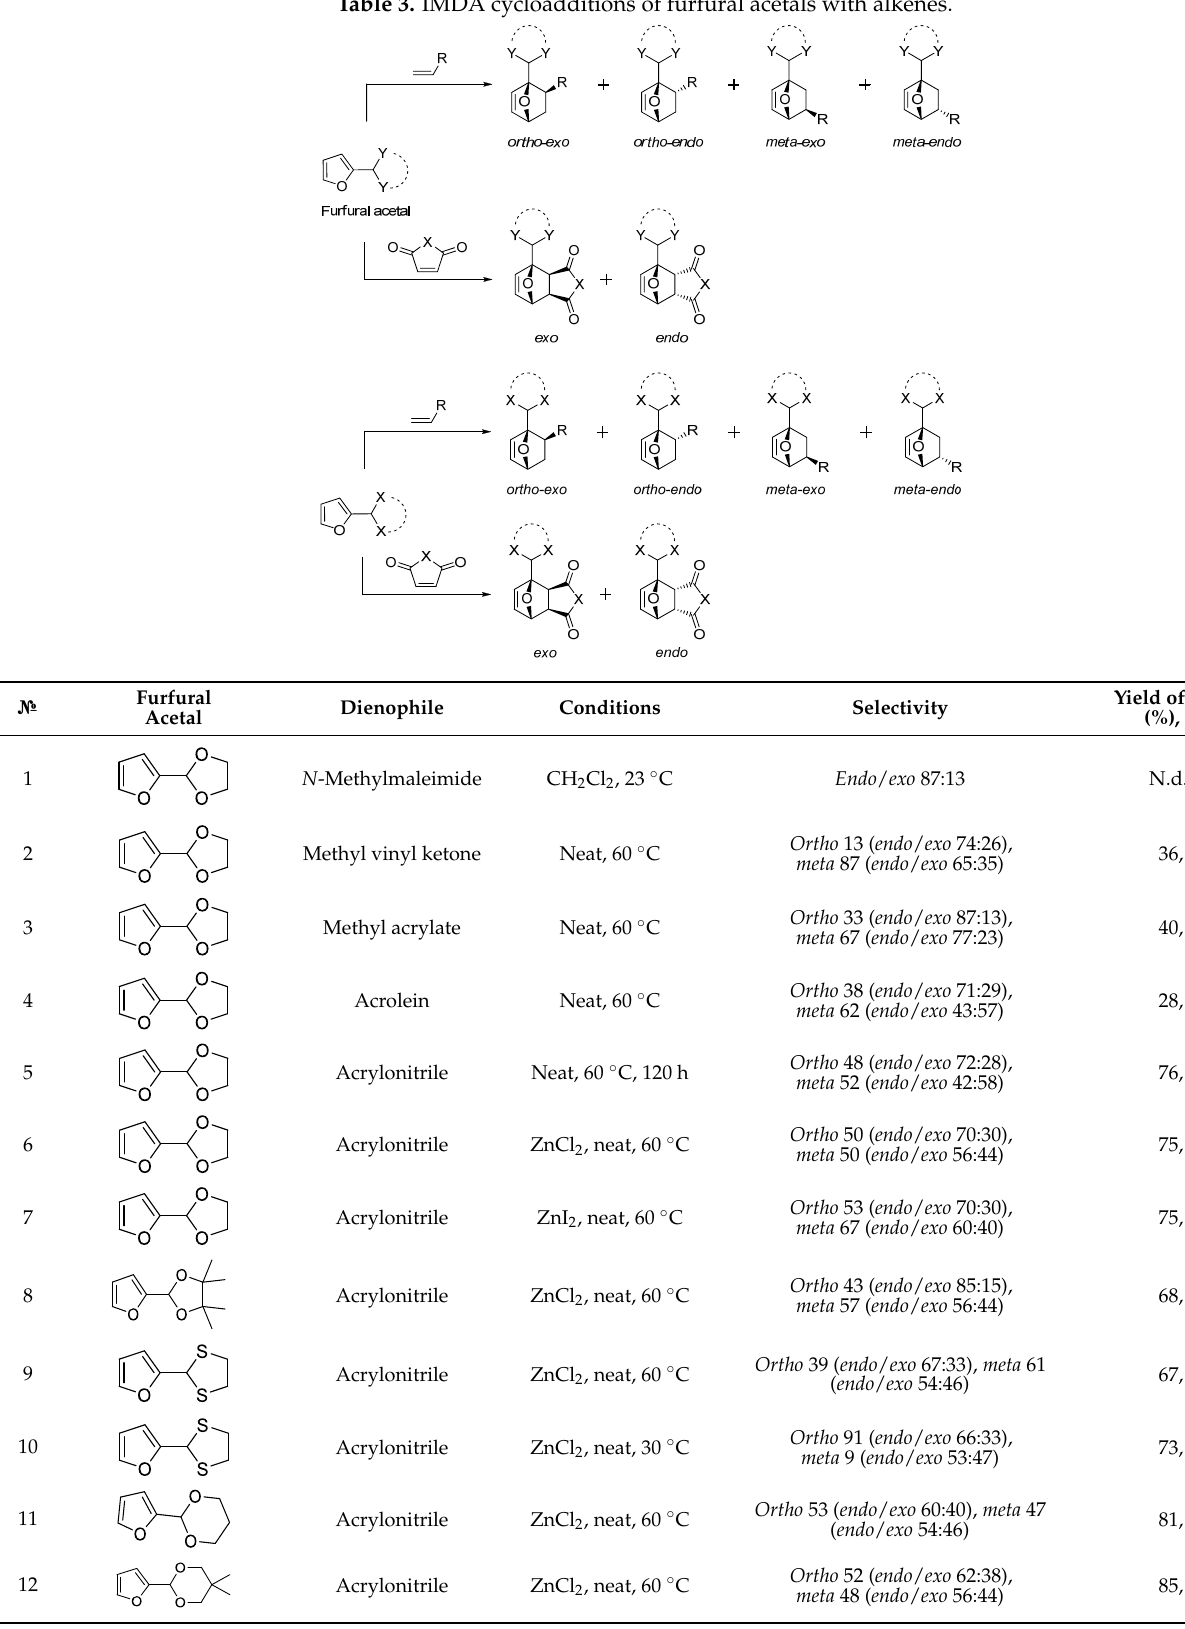
Table 3. IMDA cycloadditions of furfural acetals with alkenes.